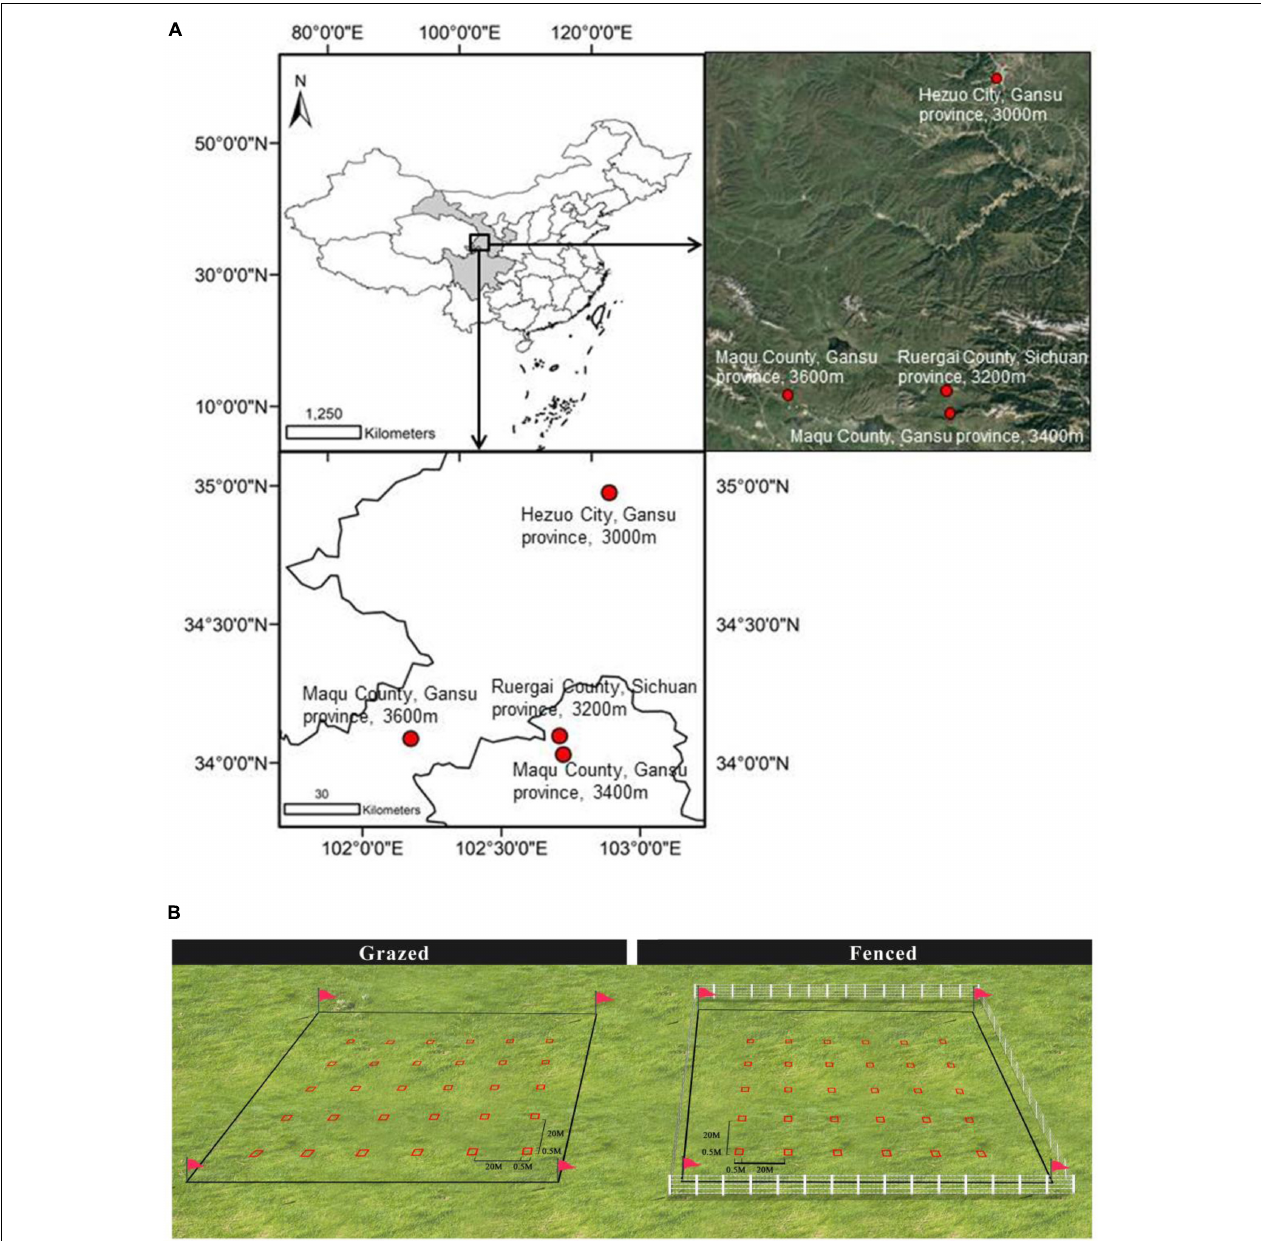
FIGURE 1 | The topographic map of the four study sites along an increasing elevation ranging from 3000 m to 3600 m above mean sea level in the eastern part of the Qinghai-Tibetan Plateau, China (A) , and the quadrat sampling design (B) . At each site, there was one overgrazed and one matched fenced meadow and 30 0.5 m × 0.5 m quadrats ware randomly arranged in both overgrazed and fenced meadows (B) .